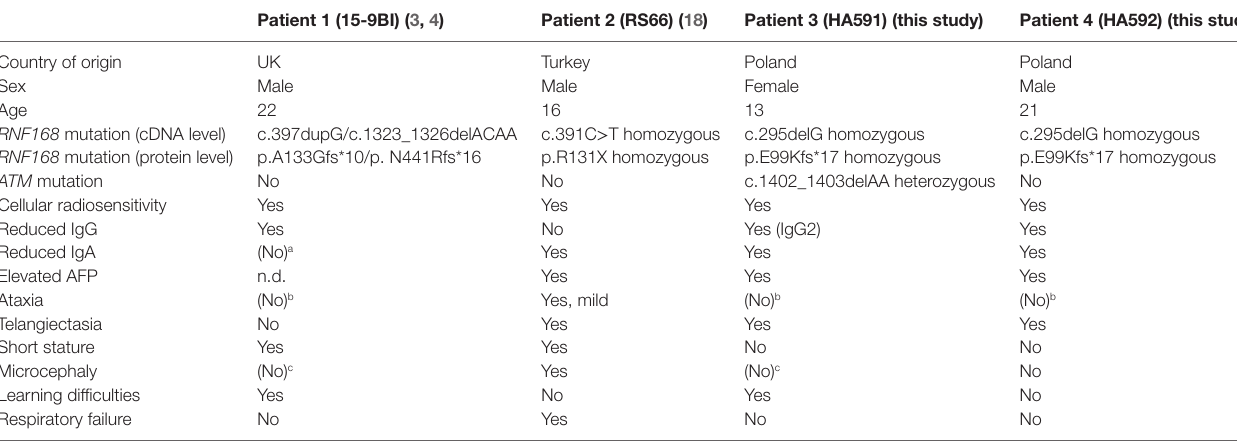
TaBle 2 | Comparison of diagnostic features of reported patients with RNF168 deficiency.